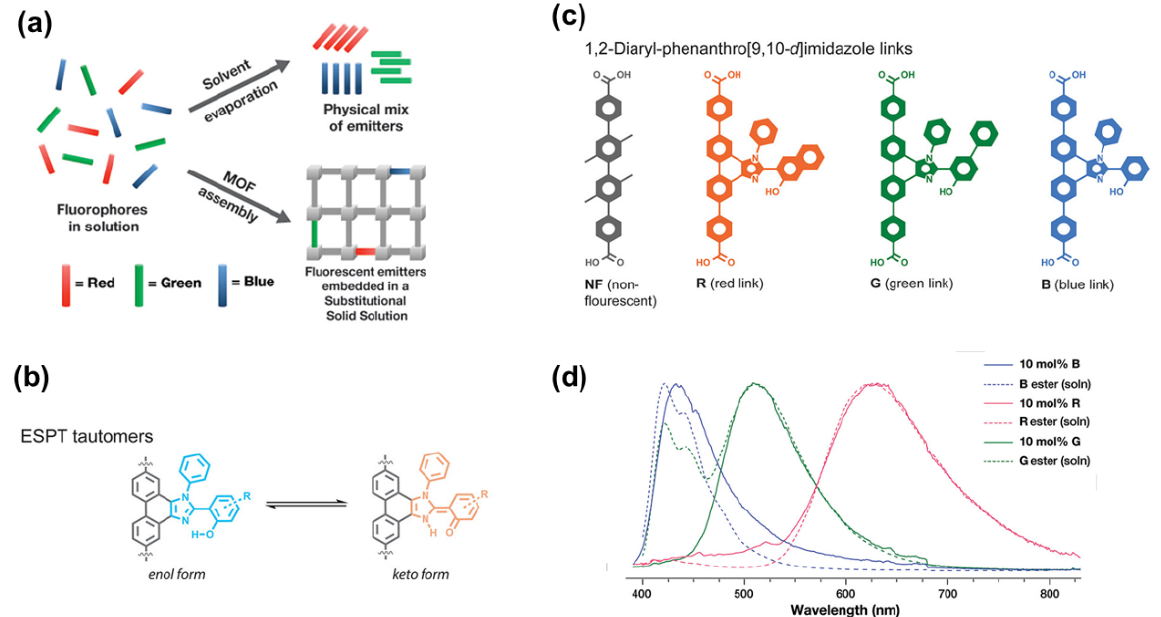
Figure 6. ( a ) Representation of luminescent MOFs based SSS. ( b ) Excited-state proton transfer enol and keto tautomer behavior of dyes. ( c ) Structure of organic linkers. ( d ) Solid-state emission of MOF with 10%-R, 10%-G and 10%-B peaks centered at 430, 510, and 630 nm. (Reproduced with permission from ref. [58]. Copyright © 2019, American Chemical Society).